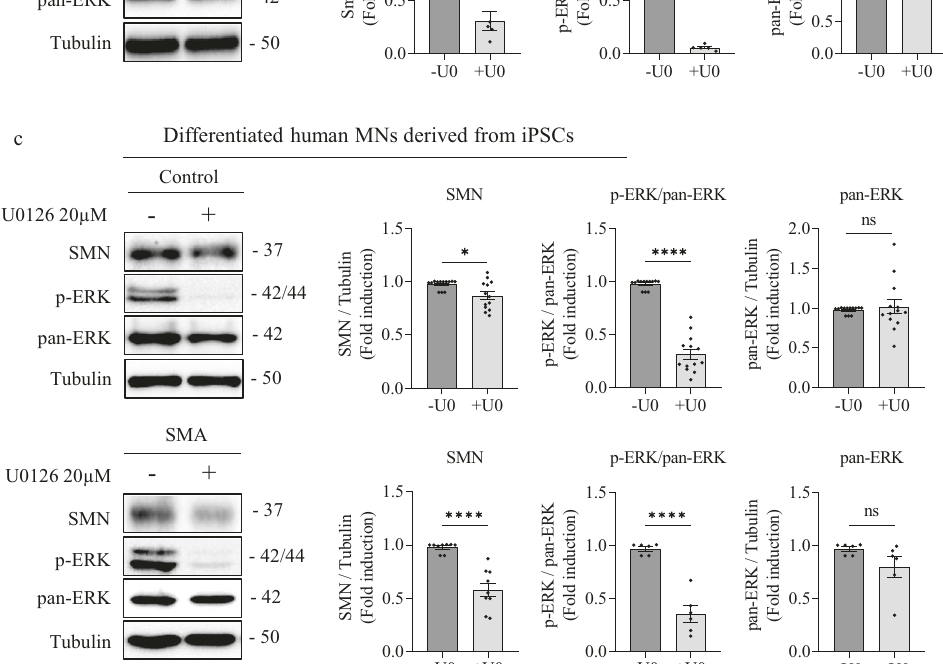
Cell Death Discovery (2023)